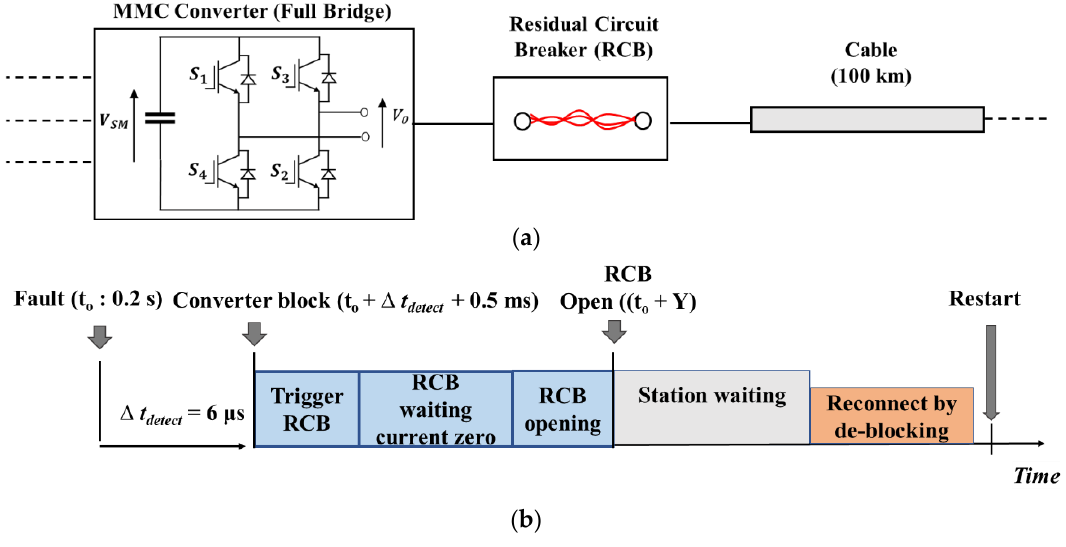
Figure 5. Case-2: DC fault handling solution composed of an FB-MMC with a residual circuit breaker (RCB): ( a ) configuration of Case-2; ( b ) operation process for DC fault handling under a DC short-circuit fault.